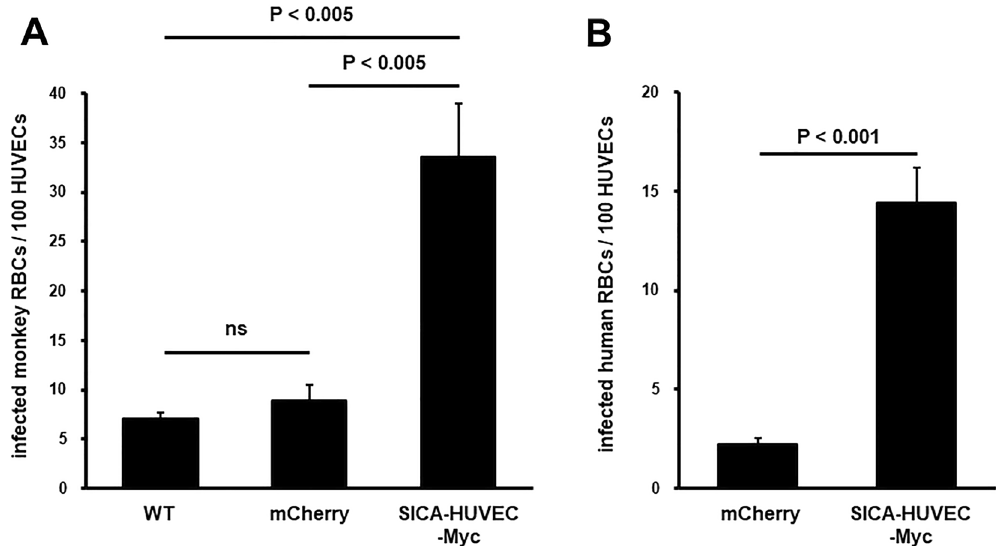
Figure 4. Cytoadhesion activity to HUVECs of monkey and human RBCs infected with transgenic parasites expressing SICA-HUVEC-Myc. ( A ) The number of infected monkey RBCs bound to HUVECs was compared among the parental wild-type parasite (WT), the transfectant expressing mCherry (mCherry), and the transfectant expressing SICA-HUVEC-Myc. ( B ) The number of infected human RBCs bound to HUVECs was compared between the transfectant expressing mCherry (mCherry) and the transfectant expressing SICA- HUVEC-Myc. Statistical differences were examined by Tukey’s multiple comparison test after one-way ANOVA ( A ) or two-tailed Student’s t -test ( B ). ns (not significant) indicates P >